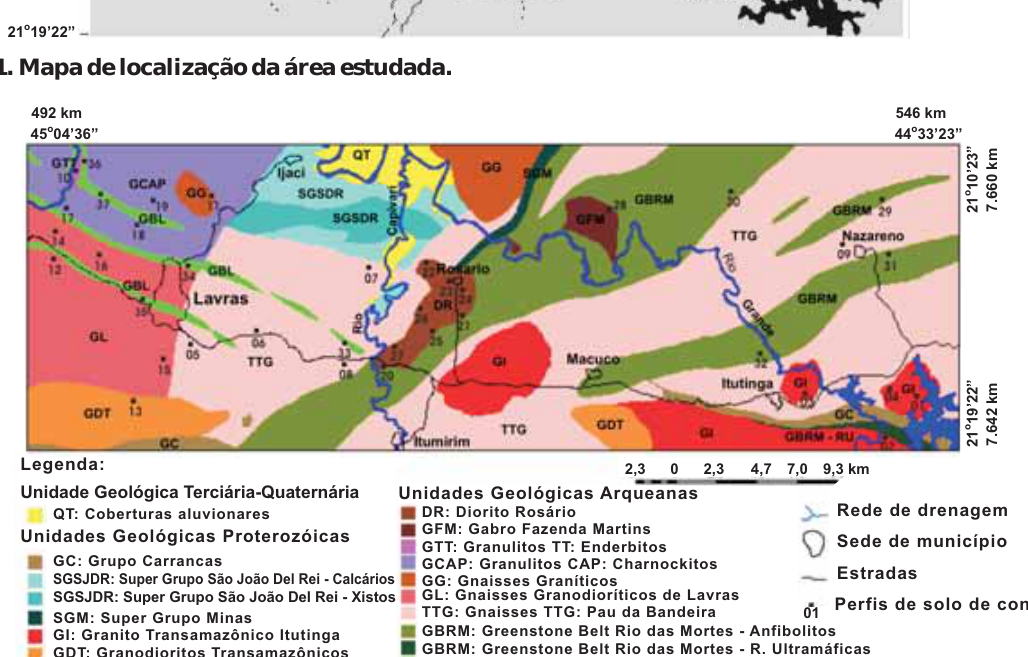
Figura 2. Mapa geológico da região de Lavras (MG) (Quéméneur, 1995), com locação dos perfis de controle